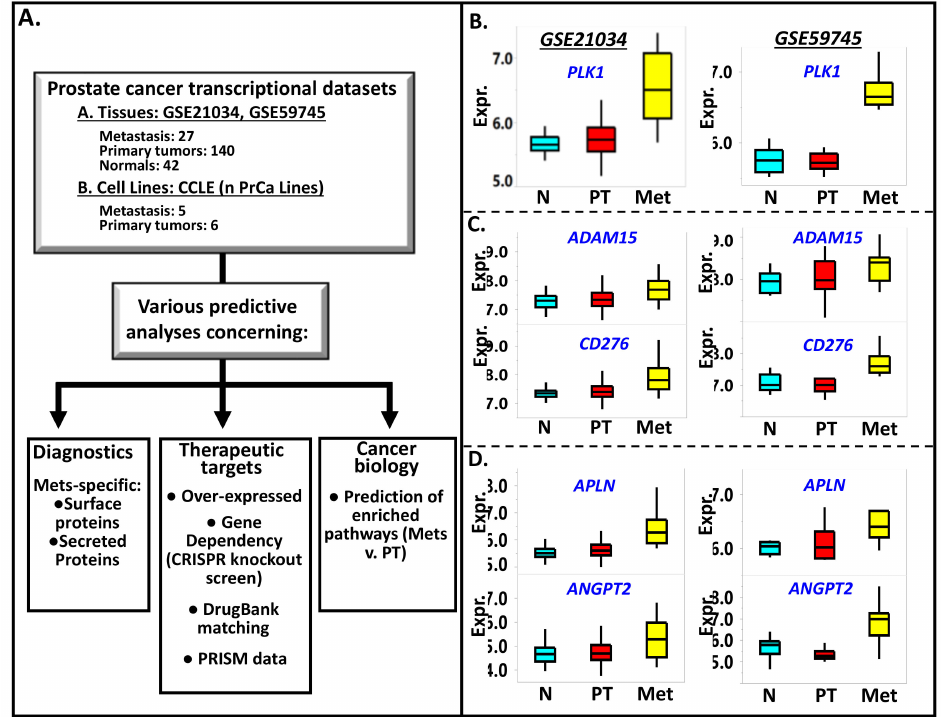
Figure 1. ( A ) The scheme on how integrated analyses of publicly available genomic and pharma- cological data, gene/protein annotations, and pathways analytical tools are employed to identify potential diagnostic markers, therapeutic targets, and relevant biology associated with prostate cancer metastasis. Examples of genes found to be highly expressed in prostate cancer metastasis (Met) relative to primary tumors (PT) and normal prostate tissues (N) are PLK1 ( B ), ADAM15 and CD276 ( C ), APLN and ANGPT2 ( D ). CD276 and ADAM15 code for surface-bound proteins while ANGPT2 and APLN code for secreted proteins. The Met v. PT p -values for each of these genes are (GSE21034 and GSE59745, respectively): PLK1 (0.002, 0.002), ADAM15 (0.002, 0.14), CD276 (0.002, 0.004), APLN (0.002, 0.03), and ANGPT2 (0.008, 0.002). On the other hand, the PT v. N expression levels of the aforementioned genes are not statistically significant, with the following p values (GSE21034 and GSE59745, respectively): PLK1 (0.25, 0.71), ADAM15 (0.09, 0.69), CD276 (0.38, 0.92), APLN (0.06, 0.74), and ANGPT2 (0.57,